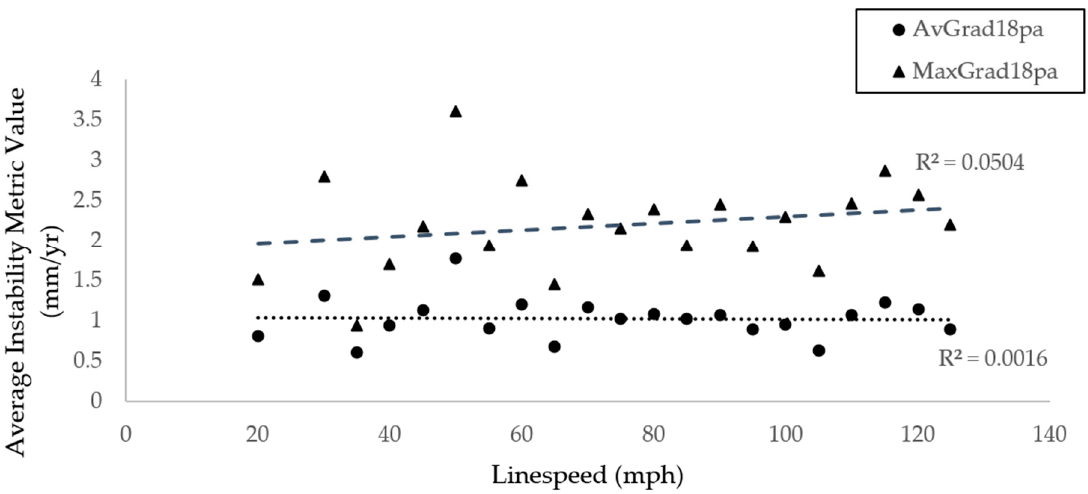
Figure 11. Graph showing variation in line speed vs. embankment instability metric value.